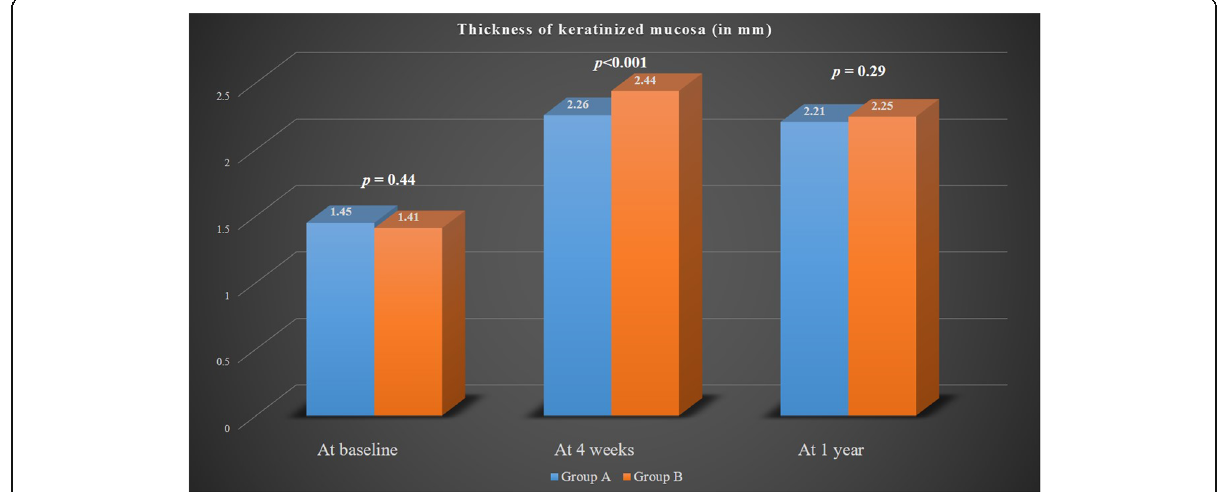
Fig. 5 Comparison of the thickness of keratinized mucosa between group A and group B at various time